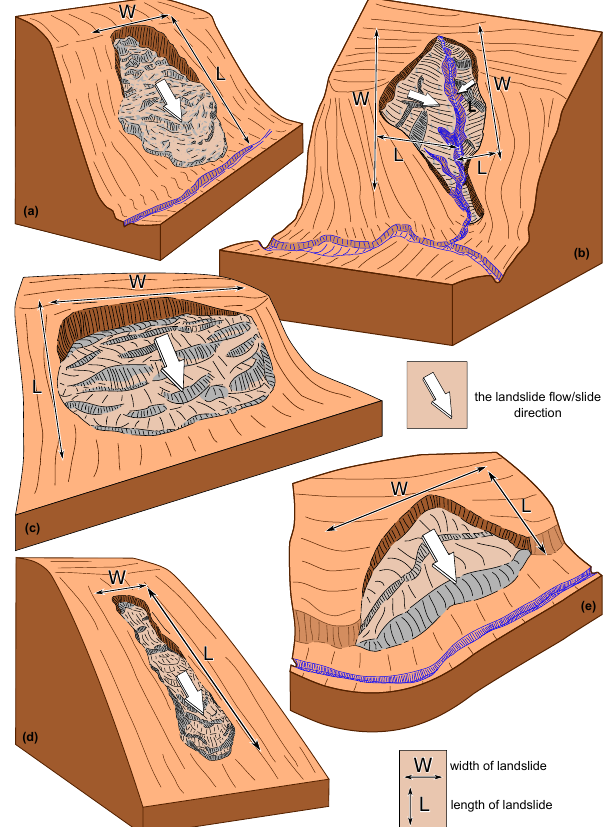
Figure 1. Schematic drawings of long and wide cases of landslides: (a) rotational slide – long type, (b) gully bank slides – wide type, (c) translational slide – wide type, (d) flow – long type and (e) river bank slide – wide